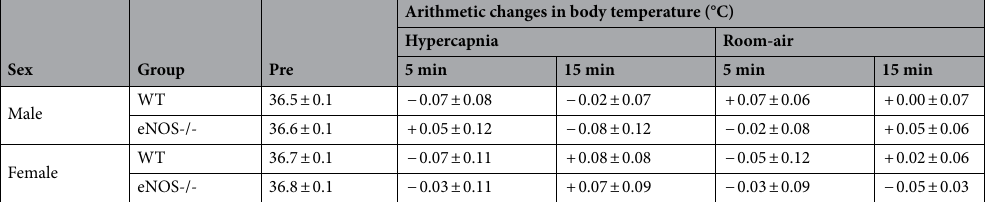
Table 3. Changes in body temperature during a hypercapnic gas challenge and upon return to room-air in male and female wild-type and endothelial nitric oxide synthase knock-out mice. The data are presented as mean ± SEM. WT, wild-type C57BL6 mice. eNOS-/-, endothelial nitric oxide synthase knock-out mice. There were 6 mice in each group. Note, there were no significant changes in body temperature or any between-group differences at any time point ( P > 0.05, for all